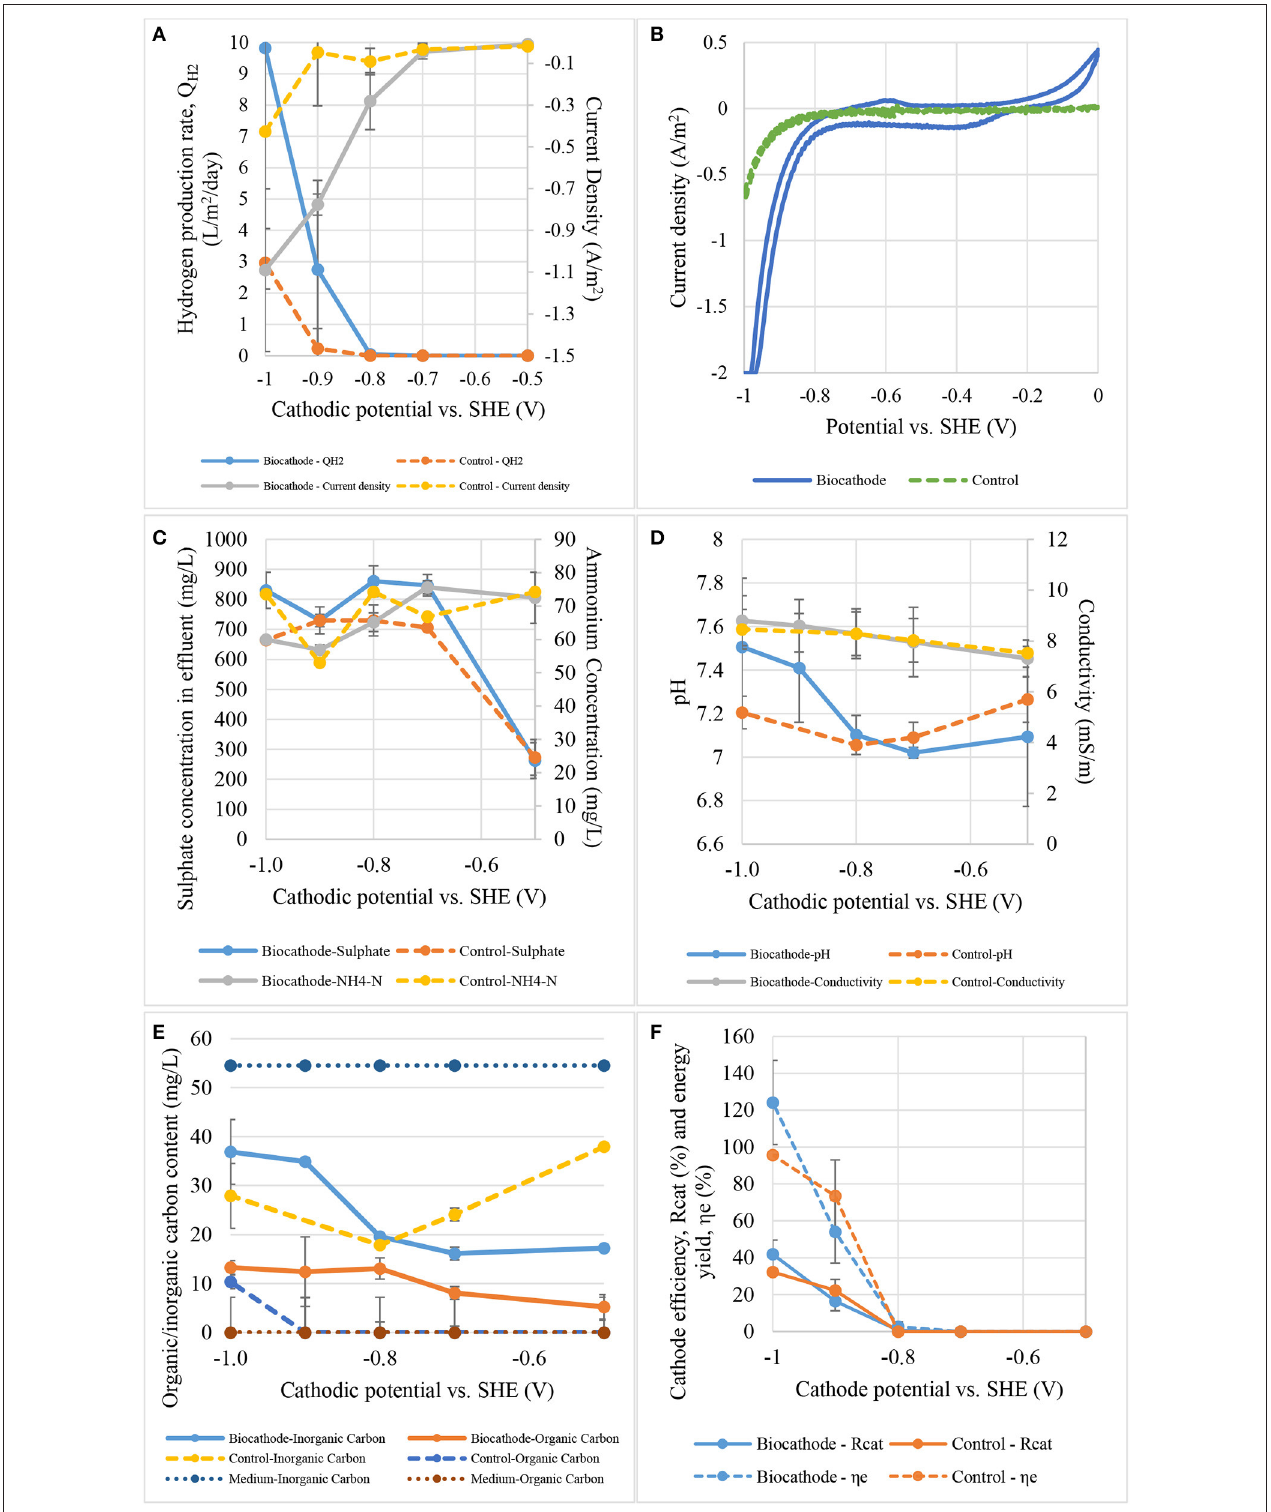
FIGURE 5 | The effect of cathode potential on: (A) hydrogen production rate and current density, (B) catalytic activity, (C) sulfate and ammonium contents, (D) pH and conductivity, (E) total carbon content, and (F) cathode efficiency and energy yield.